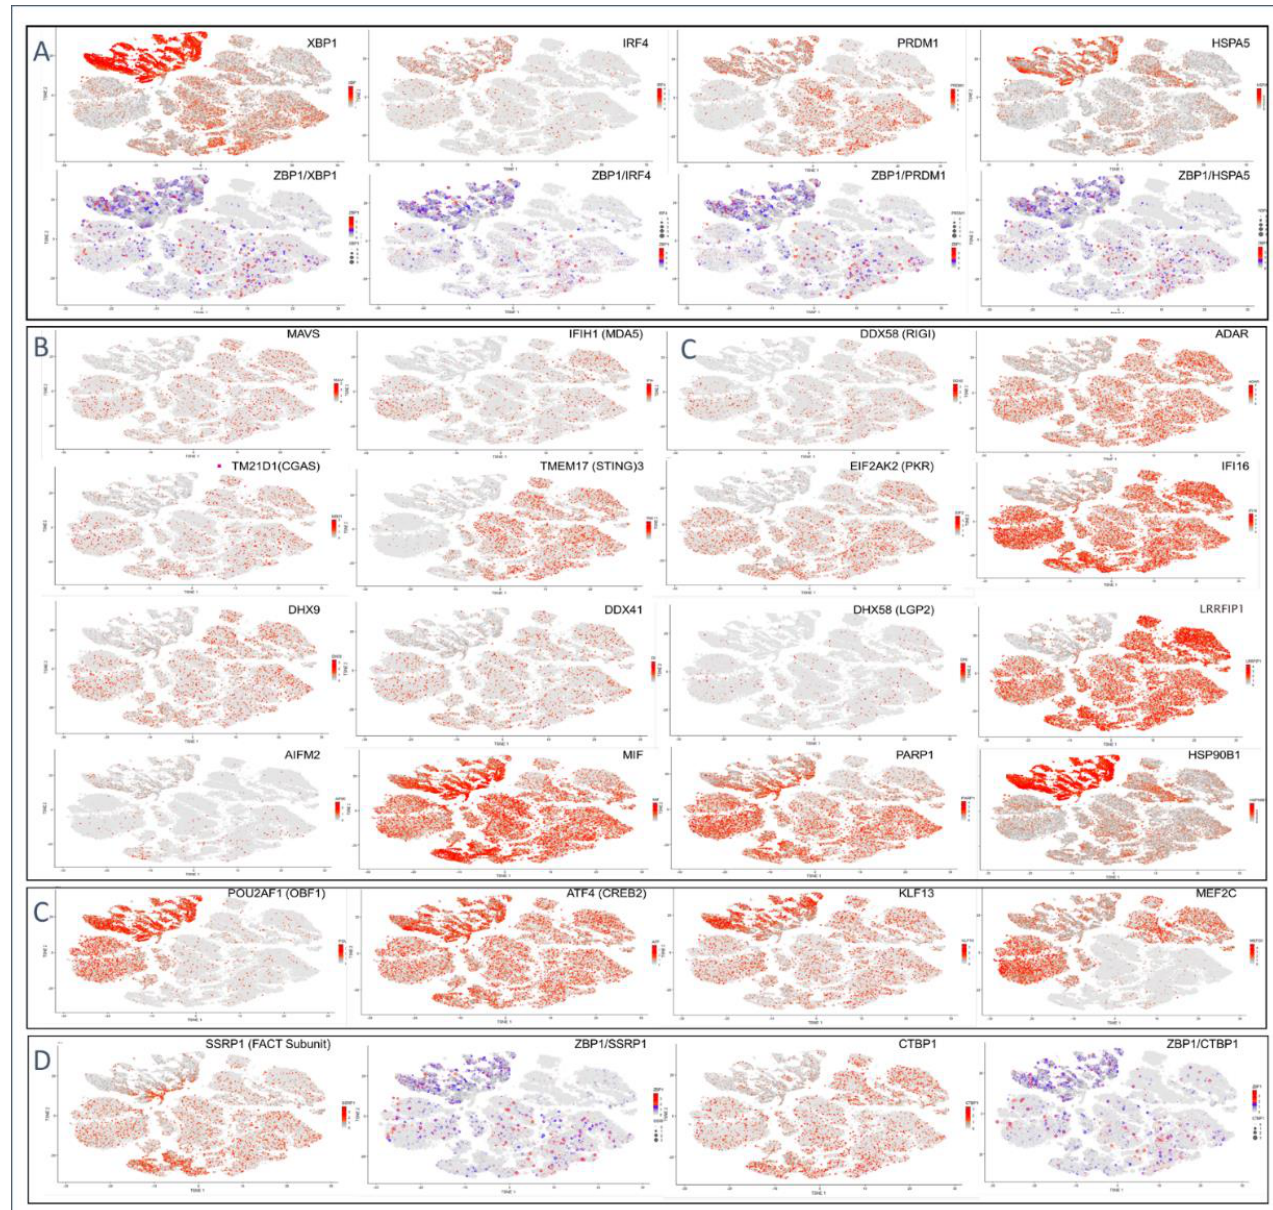
Figure 4. ( A ). Plasma cells have high expression of unfolded protein response (UPR) genes including key transcriptional factors XBP1 (X-box binding protein 1), IRF4 (interferon regulatory factor 4) and PRDM1 (PR/SET domain 1), along with the regulator HSPA5 (heat shock protein family A (Hsp70) member 5) as shown in the upper panel. The middle panel confirms coexpression with ZBP1 with the smallest dots representing cells that lack ZBP1 expression. ( B ). Expression of RNA and DNA nucleic acid sensors and their effectors show no or low coexpression in plasma cells relative to other immune cells from blood, liver and spleen (upper two rows). The expression of apoptosis inducing factor (AIFM2) is also low in plasma cells, but the effector proteins PARP1 (poly(ADP-ribose) poly- merase 1) and MIF (Macrophage Inhibitory Factor) of the ADP-dependent apoptosis pathway are robustly expressed along with the heat shock 90 protein HASP90B1. ( C ). Transcription factors ex- pressed in plasma cells belonging to gene families with proposed roles EBV gene expression [45,52]. ( D ). Coexpression of ZBP1 with the FACT (Facilitates Chromatin Transcription) component SSRP1 (structure specific recognition protein 1) and carboxy terminal binding protein 1 (CTBP1).